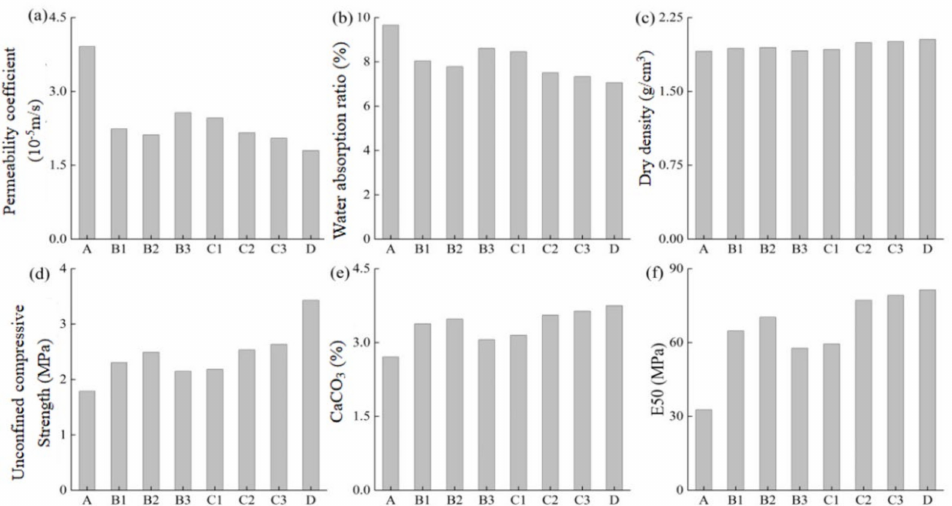
Figure 3. Physical and mechanical indicators of sand solidified with various nutrient solution compositions. Permeability coefficient ( a ); water absorption ratio ( b ); dry density ( c ); unconfined compressive strength ( d ); CaCO 3 ( e ); E50 ( f